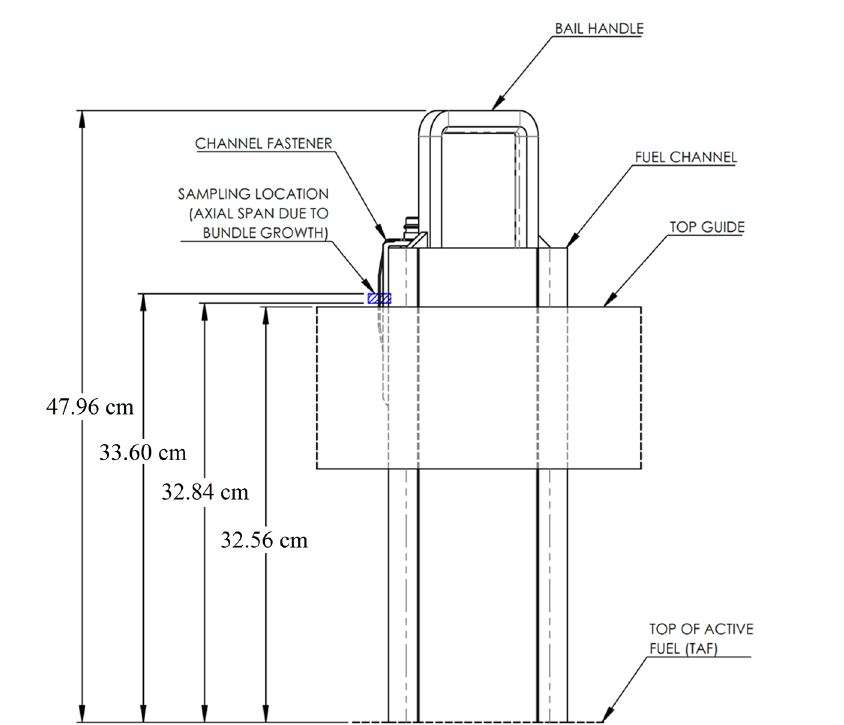
Fig. 6. Schematic representation of the channel fastener showing the locations where the fluence was calculated. The calculation accounted for channel length increase due to